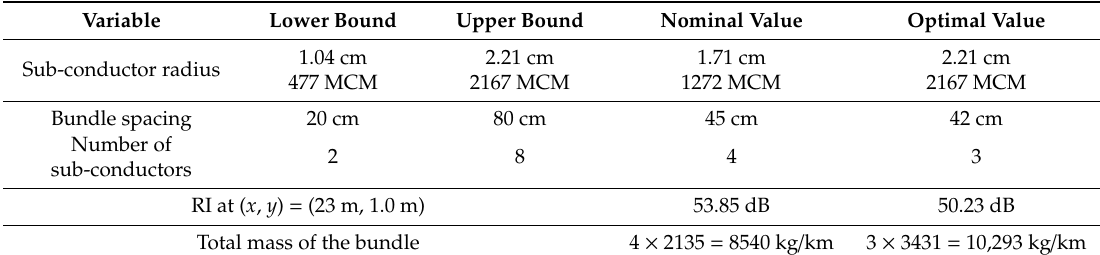
Table 5. Optimal geometric parameters for ± 500 kV HVDC line.